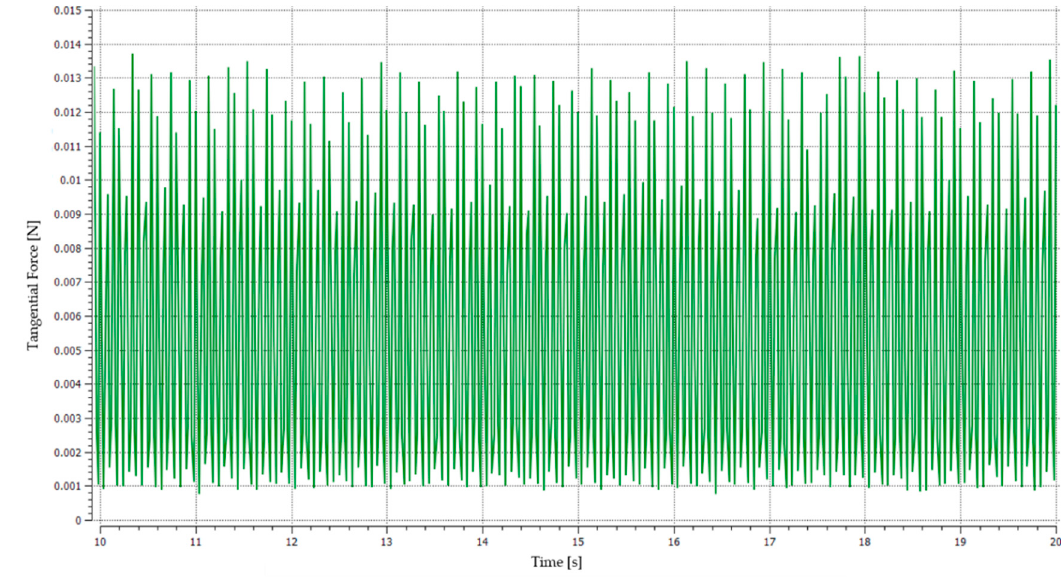
Figure 9. Average forces acting on the fruit in tangential direction vibrating transport.